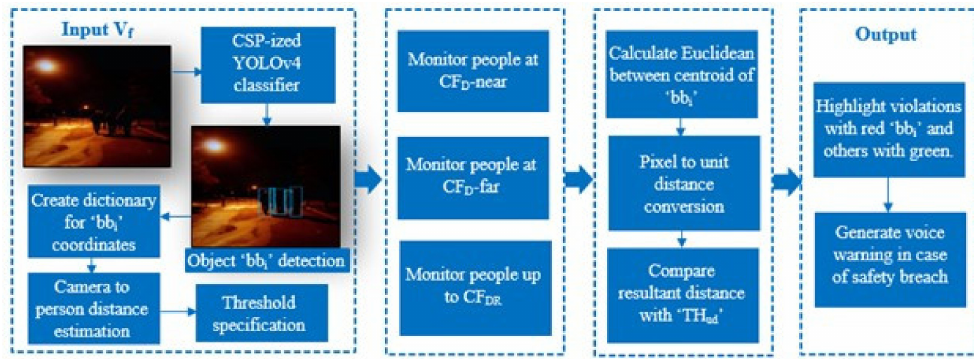
Figure 5. Workflow of the DepTSol